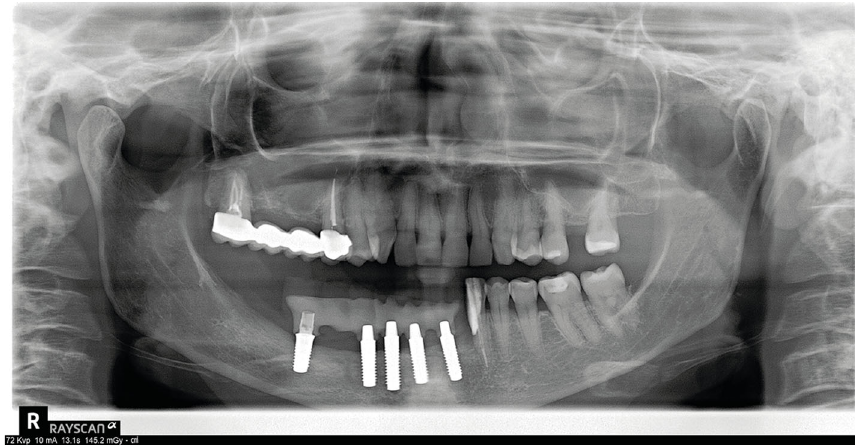
Figure 12: Rx control at 18 months of